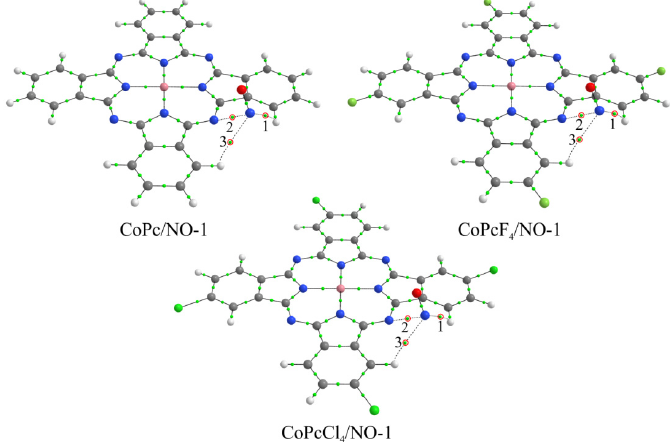
Figure 13. Structure of CoPcR 4 /NO-1 aggregates, where R = H, F, and Cl, along with bond critical points. Red circles and numbers 1–3 indicate BCPs characterizing the NO molecule interaction with phthalocyanine atoms.